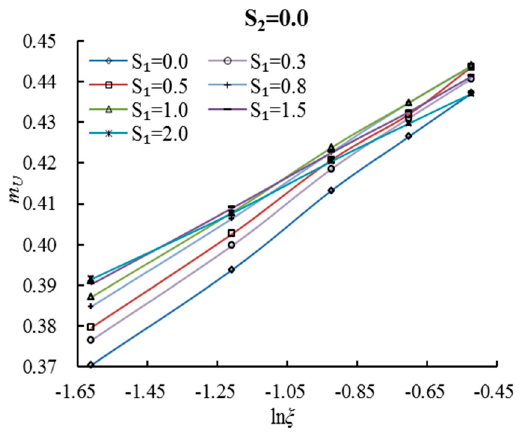
Figure 11. m U vs. ln ξ at S 2 = 0.0 for S 1 = 0.0–2.0.